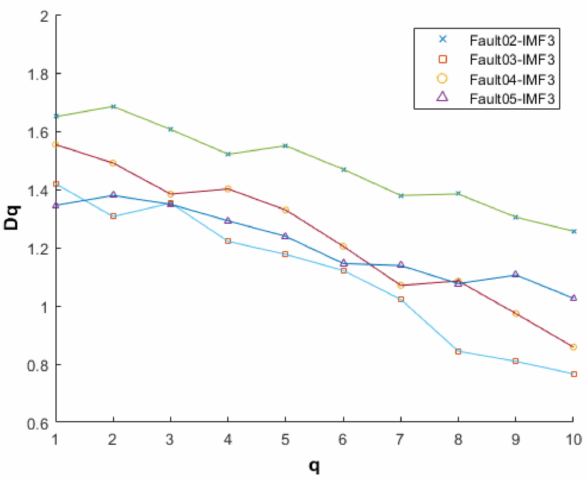
Figure 21. IMF3‑VMD box fractal dimension